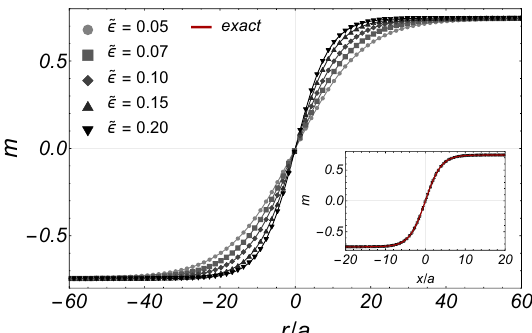
Figure 3: Steady state configuration of a domain wall in the absence of noise for different values of ˜ ε = ( Ja 2 / D ) ε as a function of position. The inset uses rescaled coordinates x / a with r = x / ˜ ε and shows that the numerical results are well described by the solution of the corresponding field theory (red solid line), Eq.